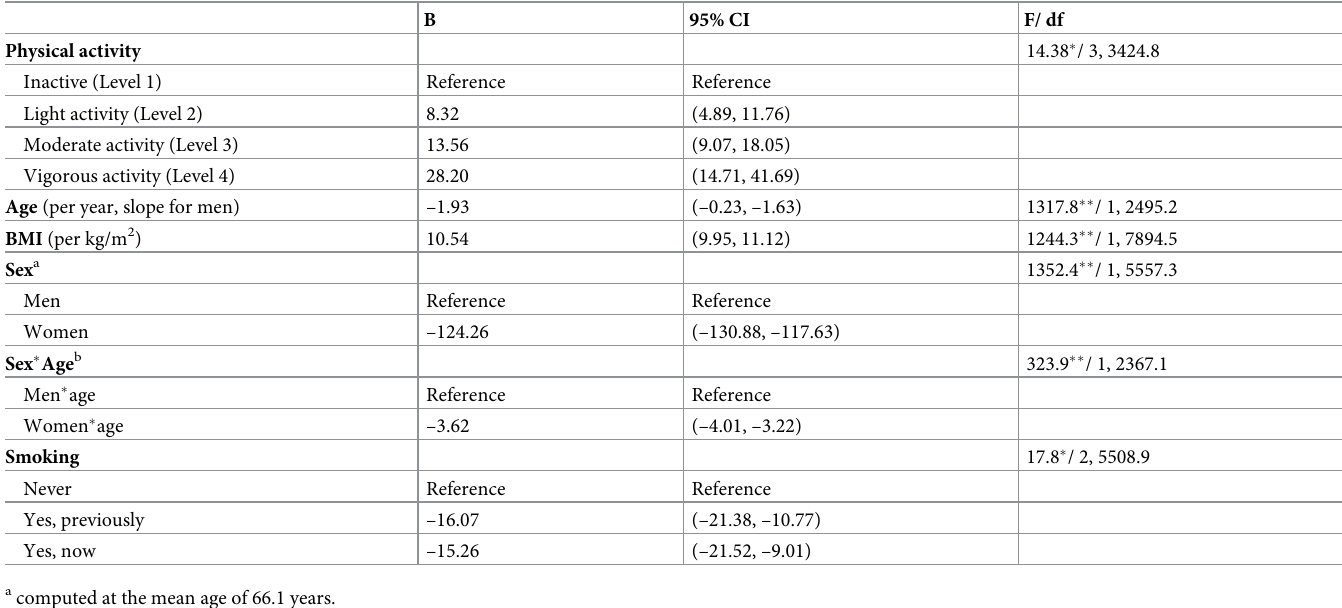
Table 2. Association between leisure time physical activity, confounders, and the left hip total aBMD (mg/cm 2 ).